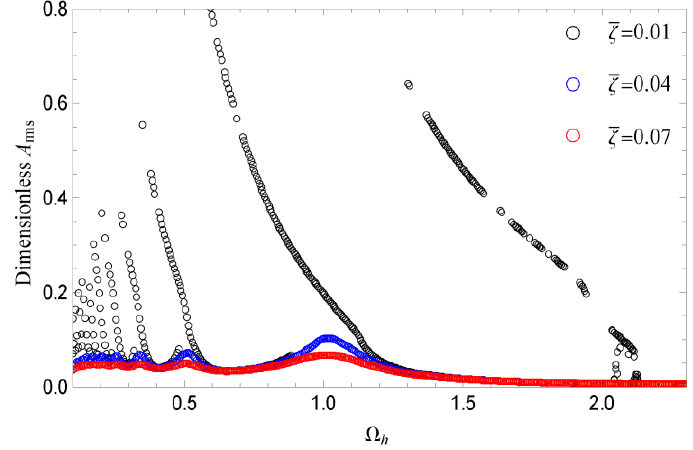
Figure 30. Curves of dimensionless 𝐴 𝑟𝑚𝑠 with dimensionless frequency 𝛺 ℎ .